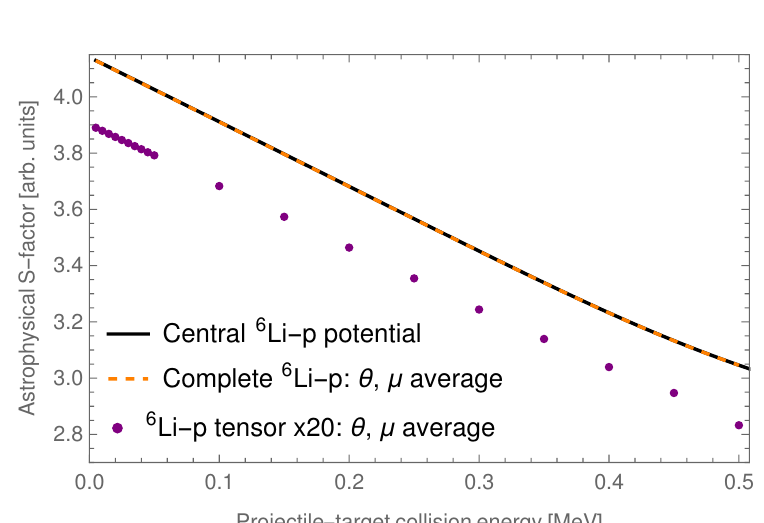
Figure 1. Astrophysical factor (see e.g. ref. [5, sec. 4] for the relevant definitions), in arbitrary units, for barrier penetration of the Li 6 –p system, computed as mentioned in section 2. The dashed orange line is the average over all configurations of the penetrability for the diagonal components of the present-work Li 6 –p form factor. The black solid line corresponds to only the central part of the same form factor. The purple points are the same as the dashed line but assuming a Li 6 –p tensor interaction 20 times bigger than computed in this